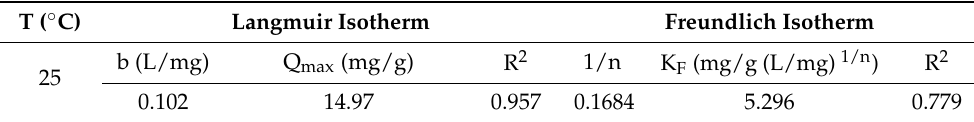
Table 4. Isotherm model parameters.